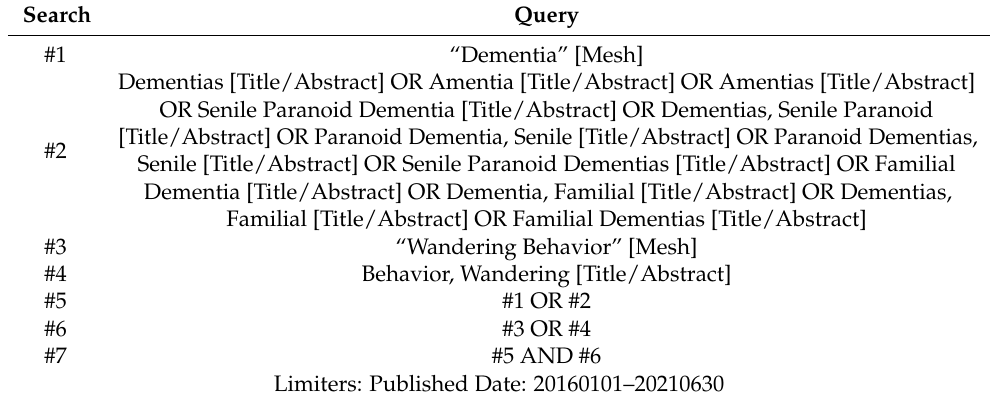
Table A2. PubMed search strategy.